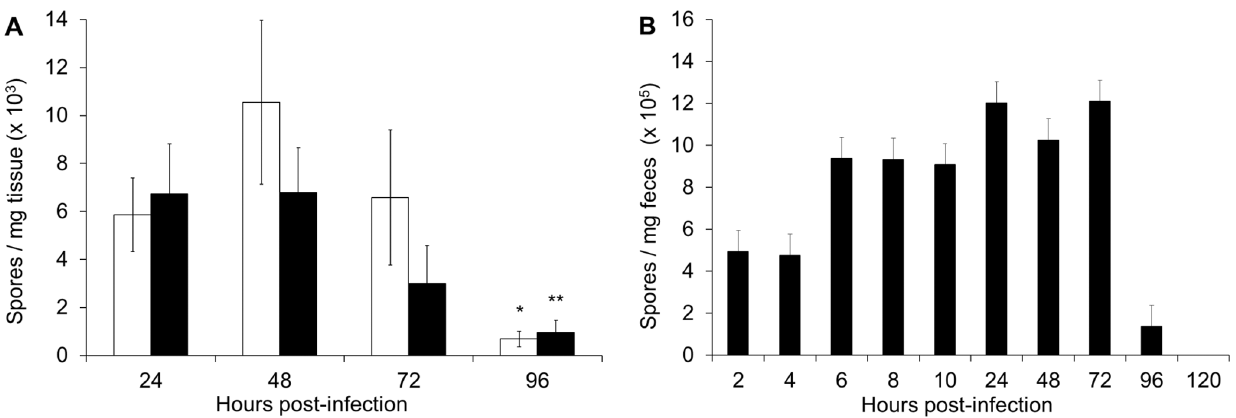
Figure 6. C.difficile spores accumulate in the cecum, colon, and feces of CamSA-treated animals. (A) Amount of C. difficile spores recovered at different time points following spore challenge from the cecum (white bars) and colon (black bars) of mice treated with 50 mg/kg CamSA. Student’s unpaired t -test was used to determine the significance of difference of means. *indicates recovered spores significantly below 72 hour levels ( P =0.019; Student’s t -test). **indicates recovered spores significantly below 72 hour levels ( P =0.049; Student’s t -test). (B) Feces were collected from cages housing five mice challenged with C. difficile spores and treated with 50 mg/kg CamSA. Closed bars represent C. difficile spores. The amount of C. difficile vegetative cells in CamSA-treated animals was negligible ( , 10% compared to spore counts). Standard deviations represent at least five independent measures. Recovered CFU and recovered spores represent mean values from a pool of five animals.